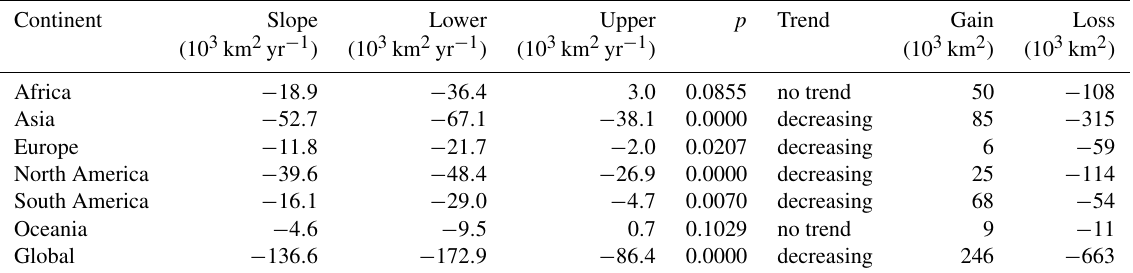
Table 11. Statistical results of change analysis for grassland (on the scale of continents). Annual change slope and its 95% confidence interval are given by Theil–Sen estimator, p value, and trend information from a Mann–Kendall test. Gain and loss areas are summarized results relating to the whole time series.